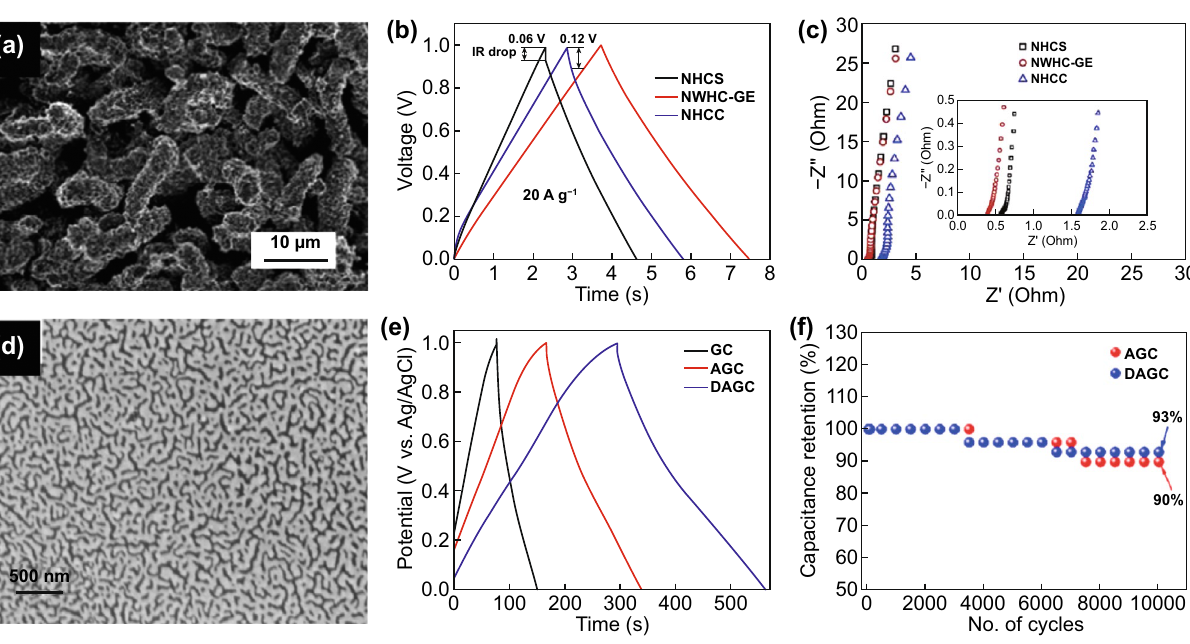
Fig. 8 a SEM images of NWHC-GE before heat treatment; comparison of ( b ) GCD curves at 20 A g –1 , and c Nyquist plot for different elec- trodes. Reproduced with permission from Ref. [128]. Copyright 2017, Elsevier. d SEM image of DAGC sheets; e comparison of (b) GCD curves at 1 A g –1 , and f Stability test for different electrodes. Reproduced with permission from Ref. [82]. Copyright 2020,